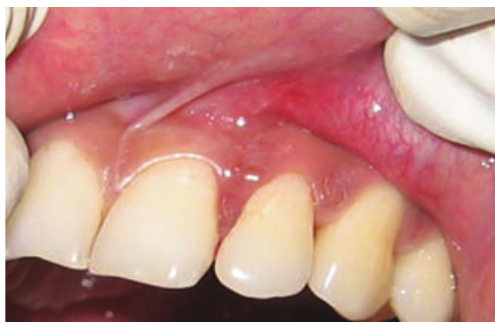
Figure 11: Closure of interdental papilla 6 months postoperatively.